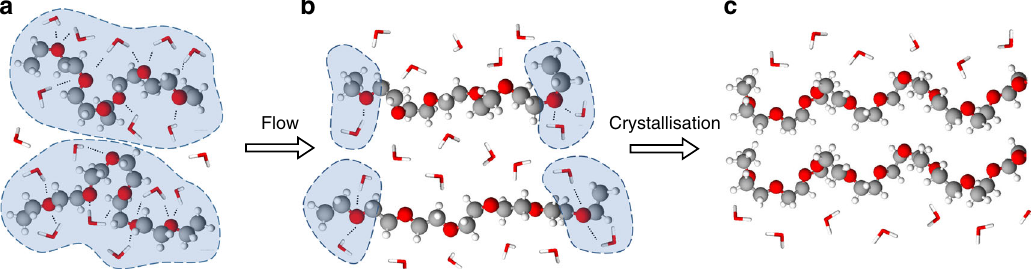
Fig. 1 A liquid to solid phase transition of PEO in a water solution. A schematic representation of the phase transition under fl ow ( fl ow-induced crystallisation of PEO in water). In the quiescent state a PEO chains are coiled globular molecules (PEO segments — ball representation, water molecules — stick representation), surrounded by a protective sheath of water molecules (blue dashed lines), which prevents PEO segments from polymer intermolecular interactions. Crystallisation is prevented by this hydration sheath even when cooled far below the melting point. However, when fl ow is applied, b molecules become oriented and stretched along the fl ow direction leading to breakage of hydrogen bonds (dotted lines) and rupture of the hydration shell. Stretched segments of desolvated PEO, similar in orientation and conformation to that of a PEO crystal are exposed to each other. Following removal of water molecules from between the chains establishing polymer intermolecular interactions, c PEO chains crystallise in a helical conformation creating a solid